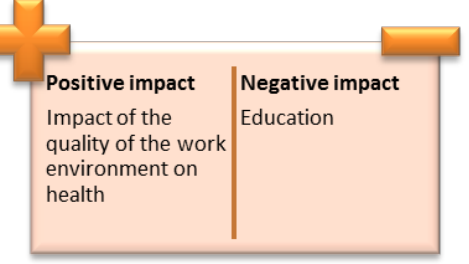
Figure 3. Factors determining the likelihood of accident or near-accident Source: Own estimates of the target survey